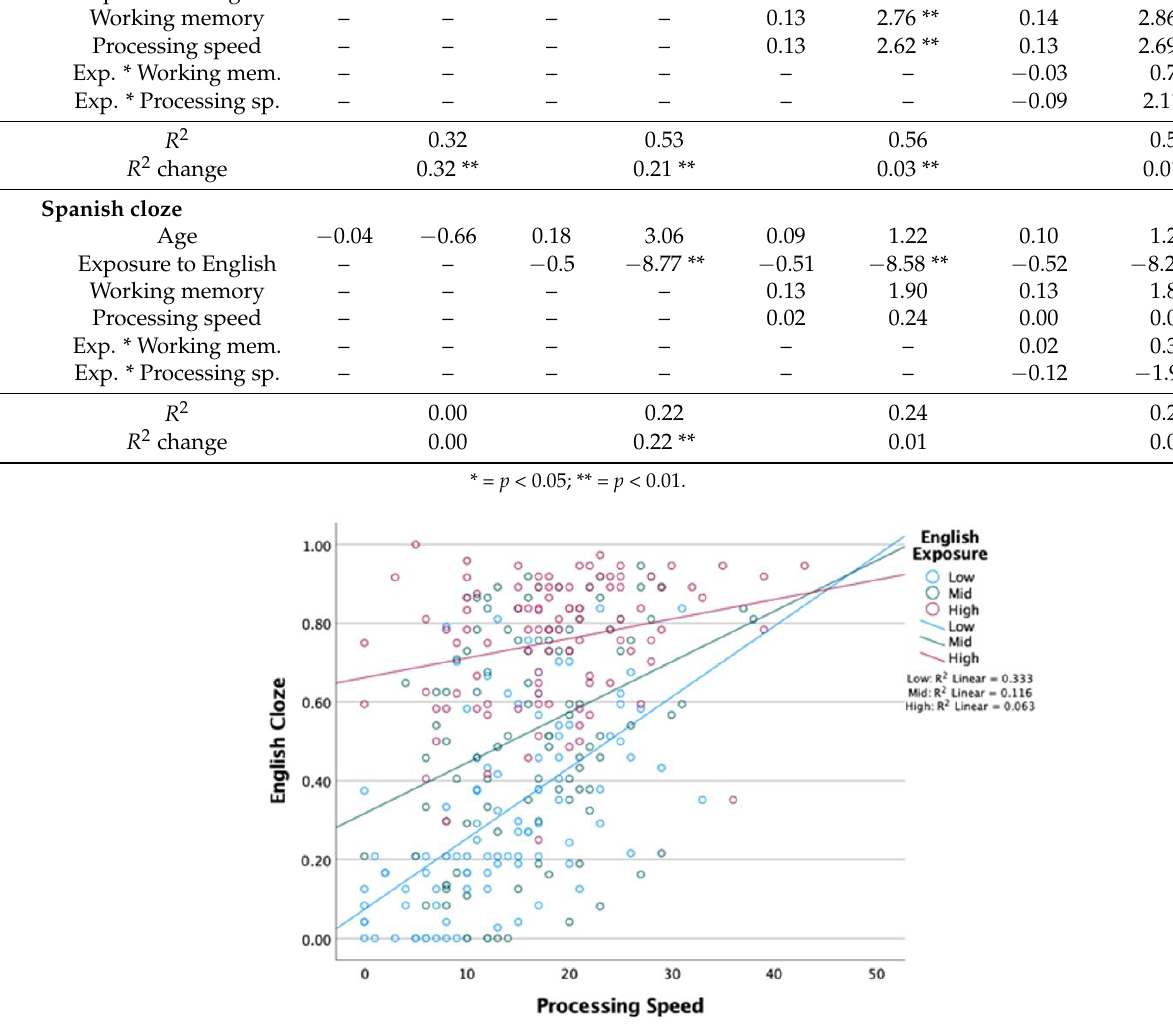
Figure 1. Scatterplot of interaction between English exposure (divided into three levels) and processing speed on English cloze performance. Spanish cloze results are shown in the bottom half of Table 4. In contrast to English cloze results, only the addition of English exposure at block 2 explained significant variability. At block one, age accounted for just 0.2% of variability, F (1, 269) = 0.412, p = 0.521. At block two, English exposure accounted for 22% of variability (adjusted R 2 = 0.22), F (1, 268) = 77.02, p < 0.01. At block three, the addition of working memory and processing speed did not significantly improve variance accounted for, F (2, 266) = 2.08, p = 0.127. Part correlations for working memory and processing speed, respectively, totaled 0.10 and 0.01, indicating that less than 1% of variance in Spanish cloze scores was uniquely explained by cognition. At block four, the addition of the interaction terms between exposure and cognition was not significant, F (2, 264) = 2.10, p = 0.124. The resulting model accounted for approximately 25% of variability in children’s English SR scores (adjusted R 2 = 0.23), with English exposure as the only significant predictor. Table 4. Model summaries of regressions predicting morphosyntax using cloze tasks.